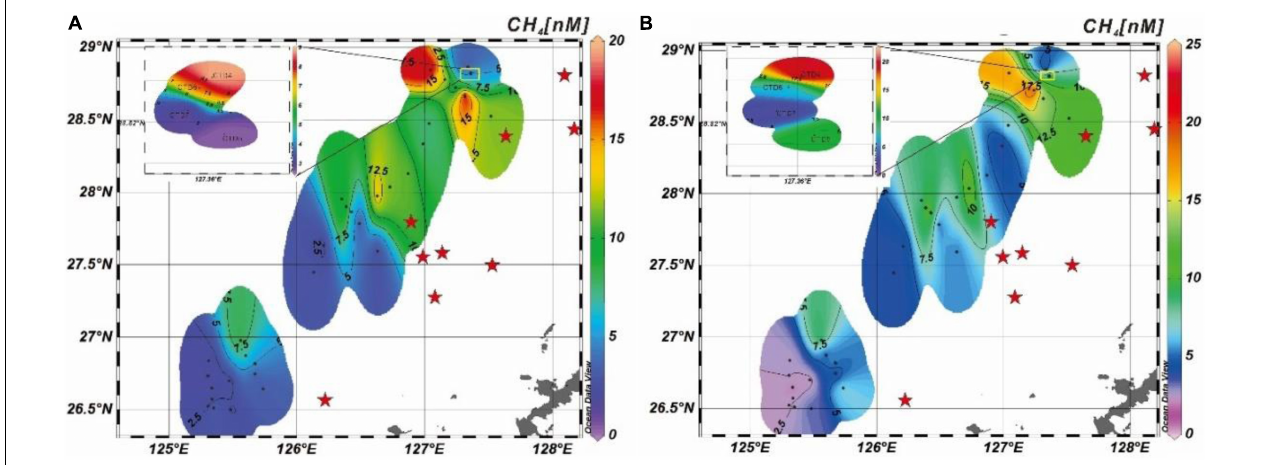
FIGURE 2 | Horizontal distributions of CH 4 in (A) surface and (B) bottom water of the OT. Red stars represent hydrothermal vent sites in the middle and northern OT, also in Figure 1 . The plots were generated using Ocean Data View (ODV) Version 5.1.0 (Schlitzer,